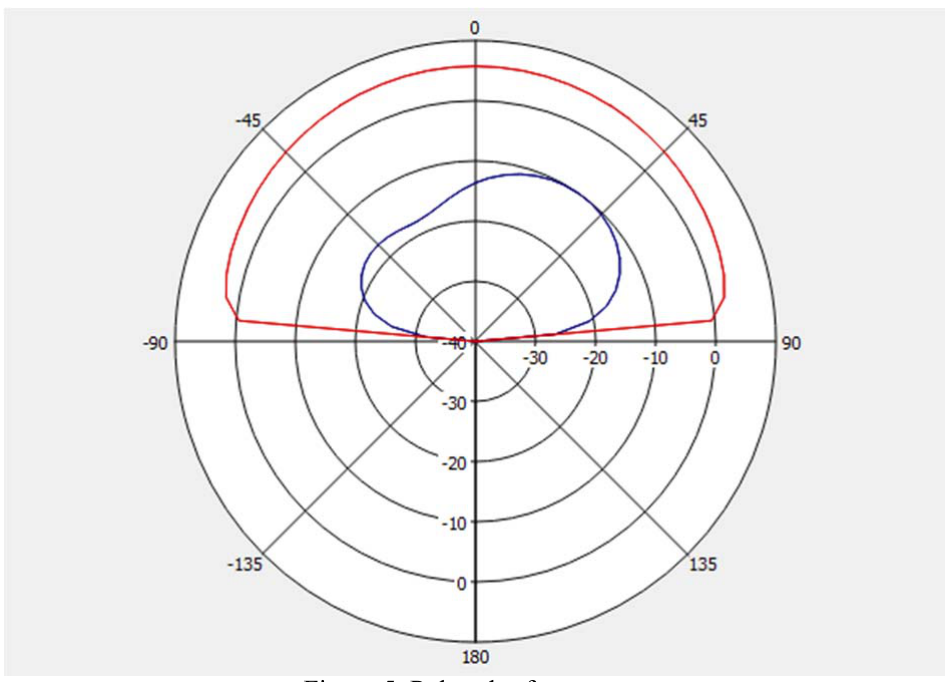
Figure 5. Polar plot for